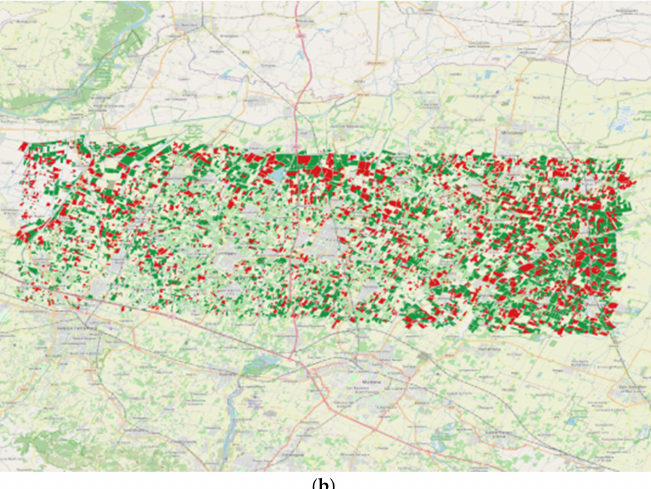
Figure 4. Irrigation maps: ( a ) Urgell site and ( b ) Emilia Romagna region (green: irrigated fields, red: rainfed